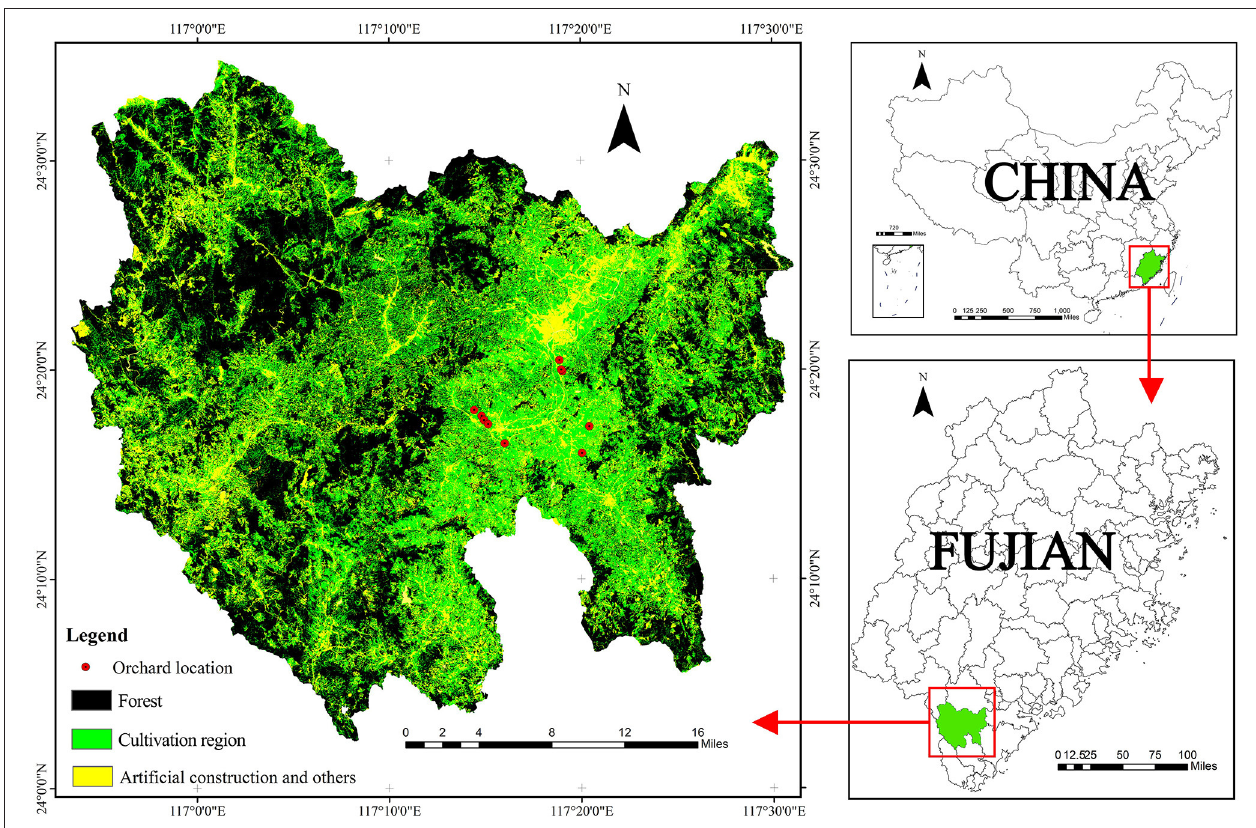
FIGURE 1 | Geographical distribution of field experimental sites within Pinghe County, China, in